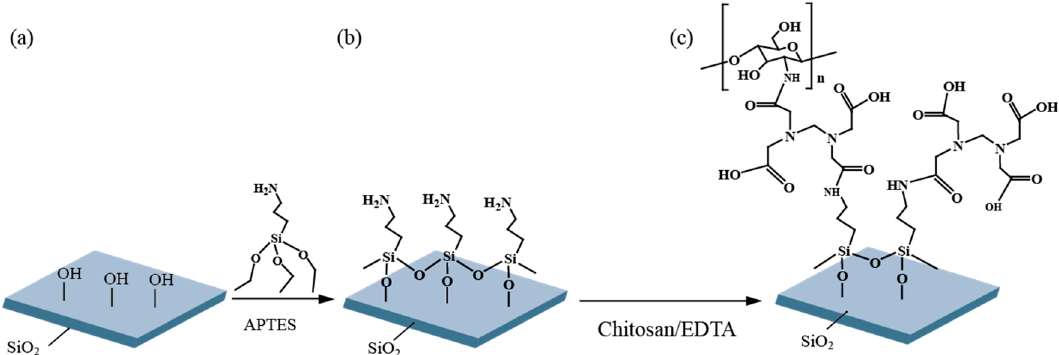
Figure 1. The functionalization of ethylenediaminetetraacetic acid (EDTA) -chitosan on silica surface: ( a ) hydroxyl group (-OH) generated on silica core surface by an oxygen plasma; ( b ) the amine group created via the silanization with (3-aminopropyl)triethoxysilane (APTES); ( c ) the EDTA-chitosan layer self-assembled through amine-carboxyl bonding.